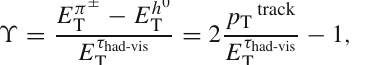
Fig. 1 Charged asymmetry distributions as defined in Eq. (3) for left- handed (left) and right-handed (right) single-prong reconstructed τ had leptons in simulated Z /γ ∗ → ττ decays after the full event selec- tion in the τ μ – τ had channel. The charged asymmetry is calculated from stable-particle level (top) and reconstructed-detector-level quantities. In addition to the inclusive distributions, the constituent distributions corresponding to generated τ leptons that decay in the τ → h ± ν and